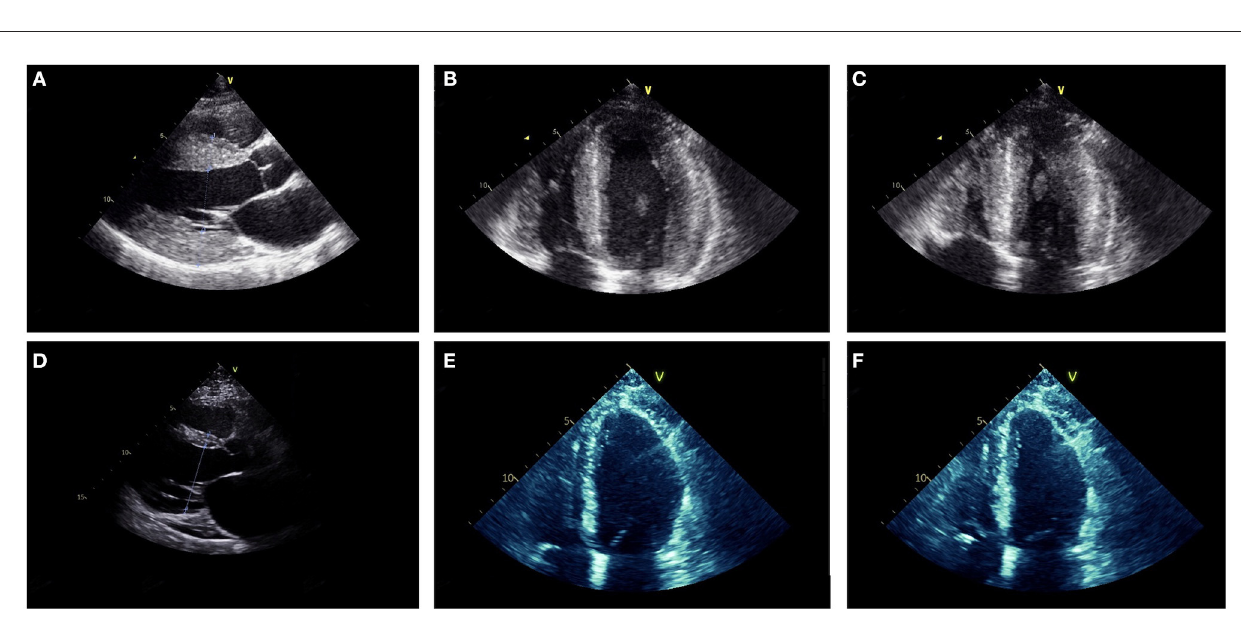
FIGURE3 Parasternal long axis (A, D) , mid-diastolic apical four chamber (B, E) and end-systolic apical four chamber (C, F) transthoracic echocardiogram images from Case 2 at ages 18 (A–C) and 27 (D–F) . At age 18, the ventricular (LV) wall was concentrically thickened (interventricular septum 20mm, posterior LV wall 20mm) with vigorous systolic function (LV ejection fraction was 60–65% by Simpson’s biplane method). At age 27, the LV wall was thin (interventricular septum 10mm, LV posterior wall 3mm) and there was moderate-severe LV dysfunction (LV ejection fraction 35–40% by Simpson’s biplane